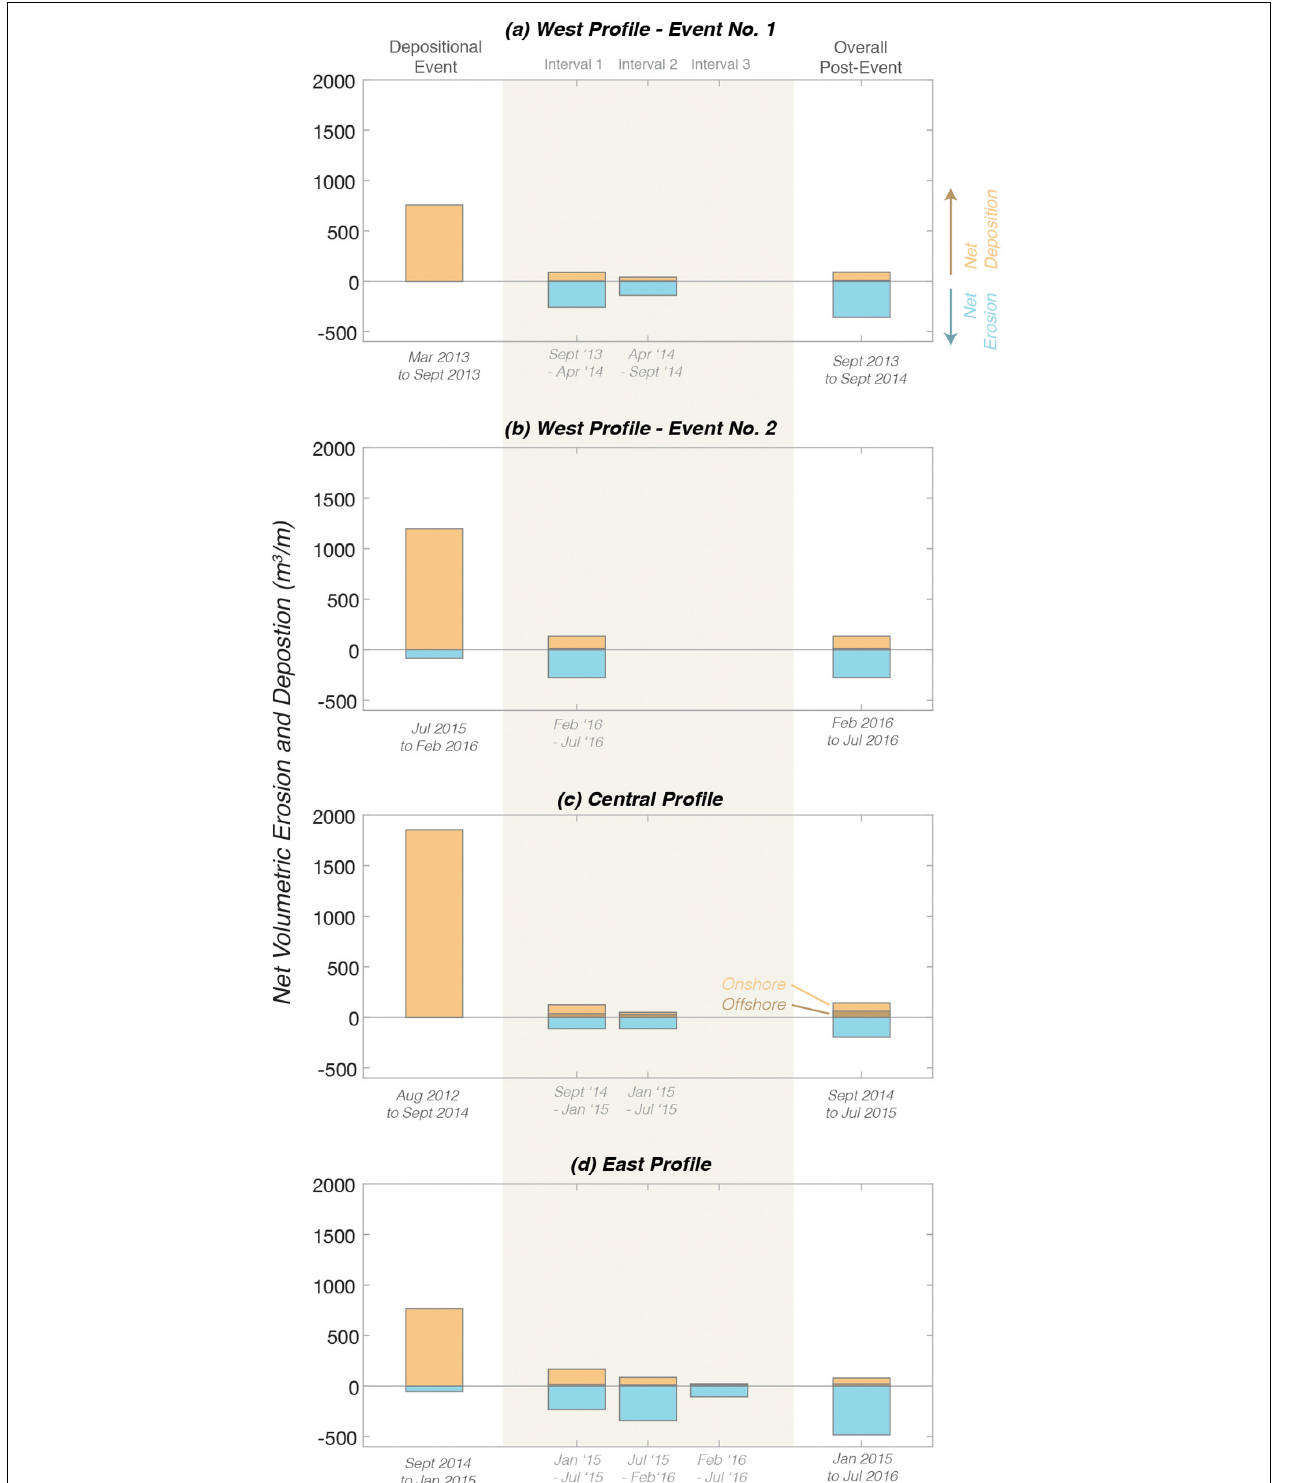
FIGURE 6 | (a–d) Volumetric change along profiles of the Elwha River mouth for the four depositional events shown in Figure 4 . Both net deposition (orange) and net erosion (blue) are shown for each interval of time. Net deposition is separated into deposition on the subaerial, or onshore, areas (light shading), and the submarine, or offshore, areas (dark shading). Results are presented for the depositional event (left-hand side) survey-to-survey intervals (center) and for the overall survey record (right-hand side). Interval dates are shown below each plot. Uncertainty in these measurements are ± 20 m 3 /m.